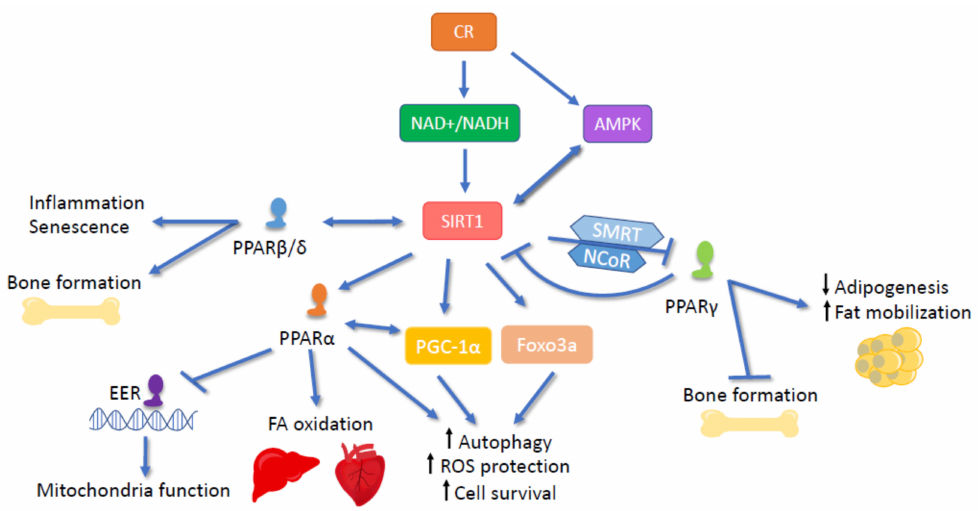
Figure 6. The interaction between sirtuin 1 (SIRT1) and PPARs. Caloric restriction (CR)-triggered energy shortage leads to the activation of SIRT1 and its interaction with PPARs. Each of these interactions results in a distinct